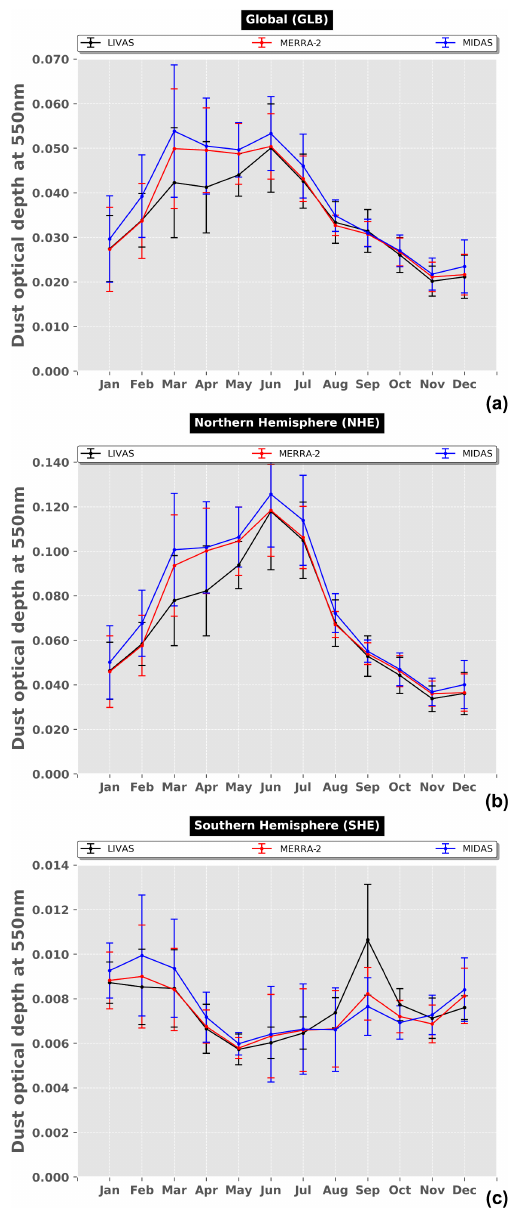
Figure 6. Monthly variability in LIVAS (black curve), MERRA- 2 (red curve), and MIDAS (blue curve) DODs, regionally aver- aged over (a) the whole globe (GLB), (b) the Northern Hemisphere (NHE), and (c) the Southern Hemisphere (SHE). The error bars correspond to the monthly interannual standard deviation computed during the period